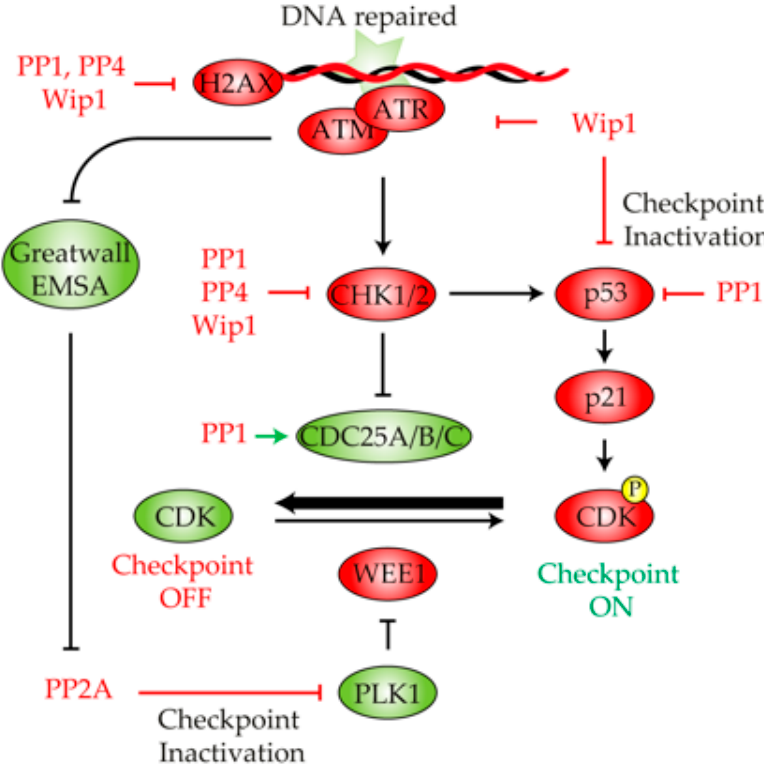
Figure 3. Role of protein phosphatases in the DNA damage checkpoint deactivation. Once the DNA lesion has been fixed, multiple phosphatases cooperate in the restoration of the phosphorylation state of multiple components of the DNA damage checkpoint pathway, thus stimulating cell cycle reactivation and recovery. PP1, PP4 and WIP1 dephosphorylate γ -H2AX and CHK1 / 2 to restrain the DNA damage signaling pathway. Wip1 also contributes to checkpoint deactivation by acting over ATM, ATR and p53. PP1 inhibits p53 and stimulates CDC25 activity, thus biasing the DNA damage checkpoint to an inactive state. The reactivation of Greatwall counteracts the PP2A inhibition of PLK1, thus inhibiting WEE1 activity. Green and red indicate active or inactive, respectively.